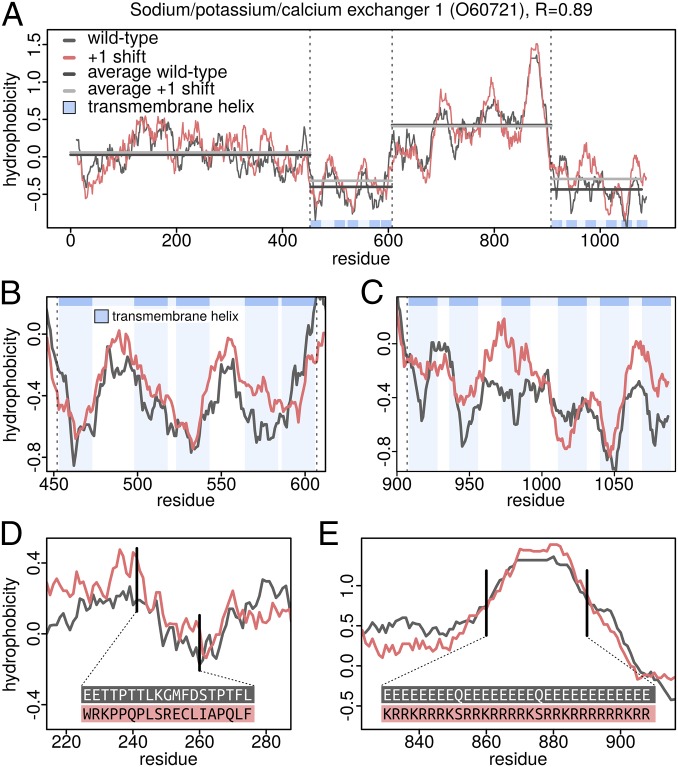
Robustness of a membrane protein’s hydrophobicity profile against frameshifting. (A) Factor 1 hydrophobicity profiles of wild-type sodium/potassium/calcium exchanger (UniProtID O60721) and its +1 frameshifted variant with relevant regions indicated with dashed lines. Close-up of the profiles in the first (B) and the second (C) transmembrane domains of the protein. Note that the specific locations of transmembrane helices are matched in all cases but one. (D) Comparison of wild-type and +1 frameshifted sequences in a region outside the transmembrane domains together with the associated Factor 1 profiles. (E) Inversion of the charge pattern upon +1 frameshift with a retained hydrophobicity profile.